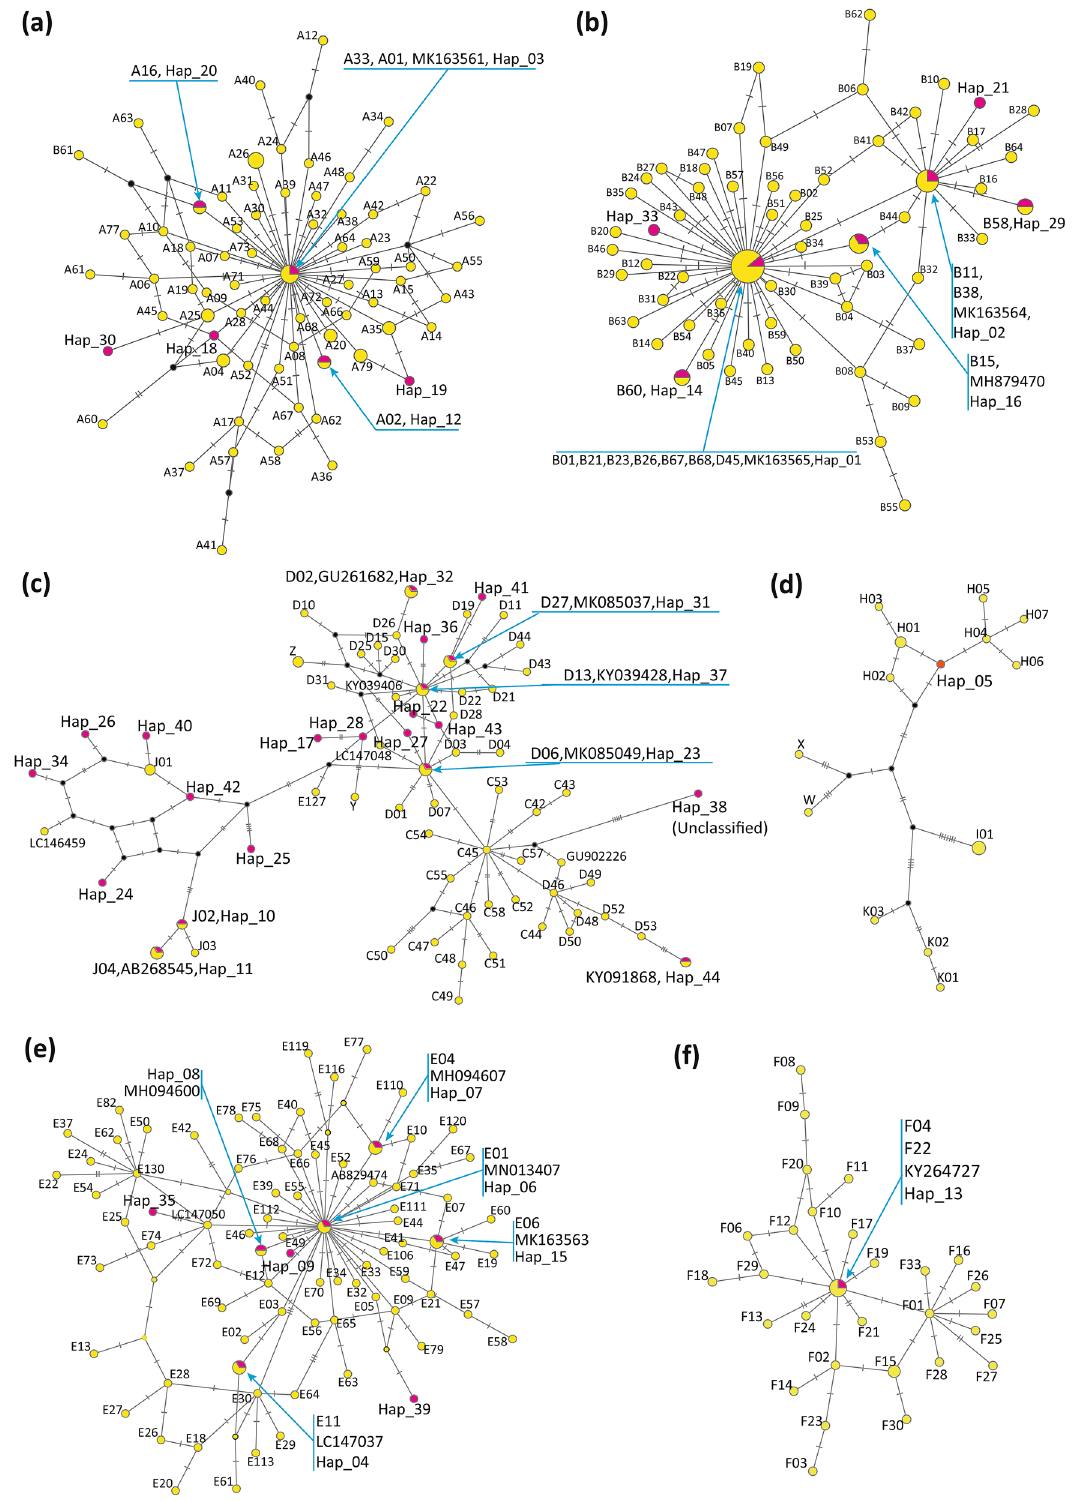
Figure 2. Locations of mtDNA D-loop haplotypes of Thai red junglefowl and indigenous chicken populations in the global chicken population network. ( a ) Haplogroup A. ( b ) Haplogroup B. ( c ) Haplogroups CD, Y, Z, J, and an unclassified haplotype, Hap_38. ( d ) Haplogroups H, I, K, X, and W. ( e ) Haplogroup E. ( f ) Haplogroup F. Haplotypes that were found in the present study and representative haplotypes reported by Miao et al . 5 are shown by magenta and yellow circles, respectively. Black nodes are the inferred intermediate haplotypes. The number of bars on the lines, which link haplotypes, represent the number of nucleotide substitutions that occurred between the haplotypes for